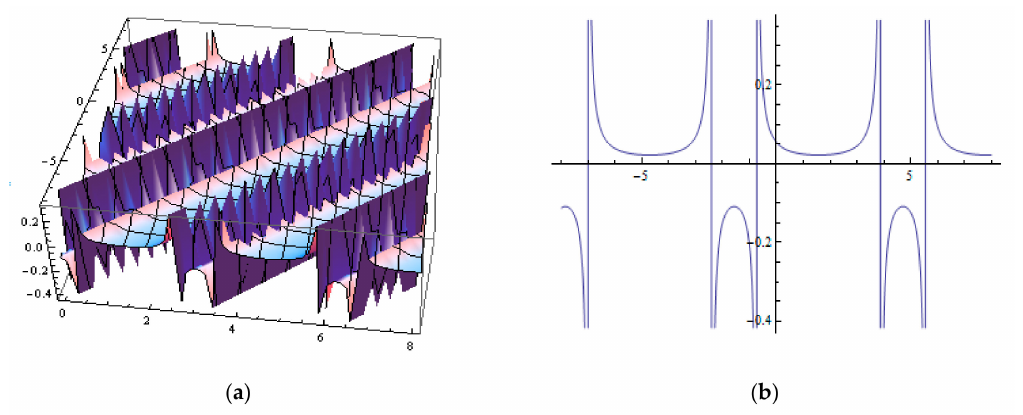
Figure 1. ( a ) The Absolute value of exact solution Q 1 when s 0 = 2, ε = 0.2, α = − 2, σ = 0.1, η = 2, ζ = 1, A = 3 and B = 2 and ( b ) is the projection Q 1 in 2D.